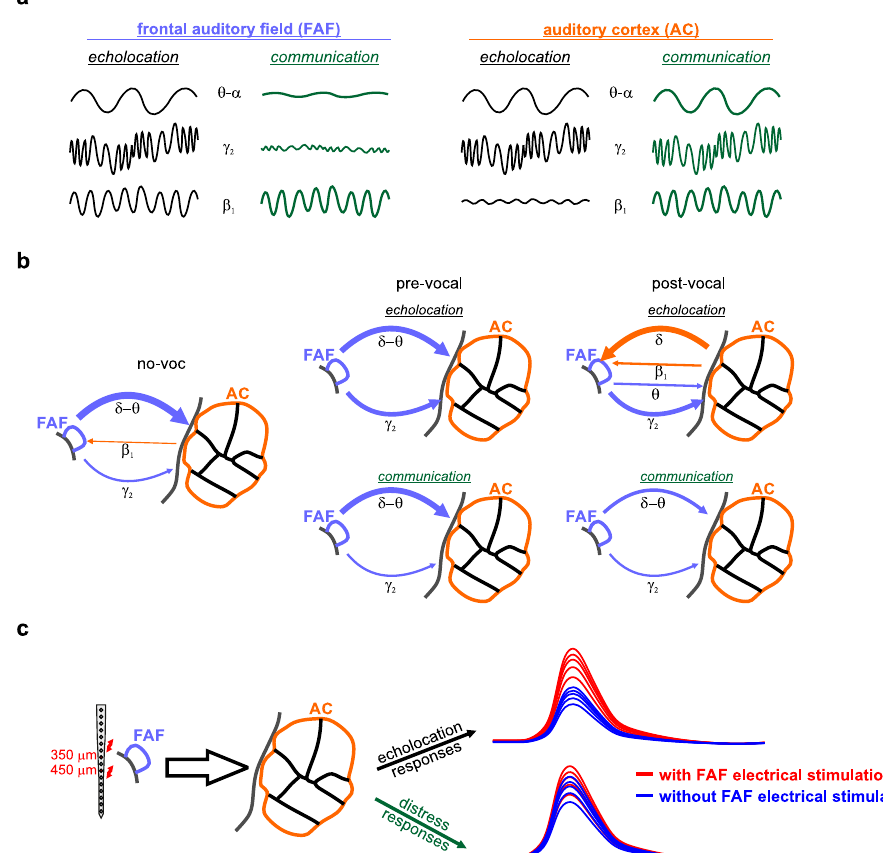
Fig. 6 The FAF-AC network during vocal production. a Oscillations in frontal and auditory cortices provide a neural correlate of vocal production, allowing the prediction of ensuing call type. Prediction is possible in complementary frequency bands in each region, and with opposite effects. b Schematic representation of causal interactions (within a TE framework) in the FAF-AC network. Strong top-down control, mostly in δ and γ frequencies, occurs during spontaneous activity (no-voc) and prior to vocal utterance. In the δ -band, information fl ows top-down in the circuit (FAF → AC) during pre-vocal periods, but changes to bottom-up (AC → FAF) information transfer during post-vocal periods. The directionality patterns and the strength of preferential causal interactions depend on the type of call produced, and on the timing relative to vocal onset. c Electrical stimulation results provide strong support to the notion that FAF alters the manner in which AC processes acoustic information, preferentially when animals listen to echolocation sounds. In comparison to the listening of distress sounds, auditory cortical responses to echolocation sounds were more reliably enhanced after electrically stimulating the frontal